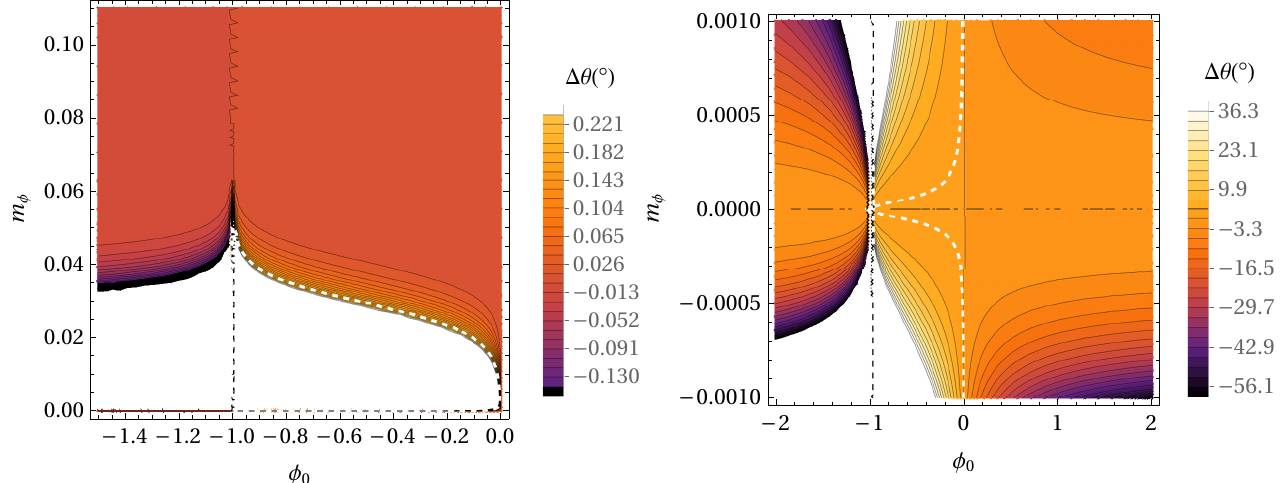
Figure 5. The precession per orbital period for the φ 0 - m φ parameter space in the case of the Hybrid Palatini gravity potential without extended mass distribution in the case of the S55 star. With a decreasing value of the precession angle, the colors are darker. Parameter m φ is expressed in AU − 1 . The white dashed line depicts the locations in the parameter space where the precession angle has the same value as in GR (0 ◦ .10). The right panel represents the same as the left panel but for smaller values of the m φ parameter.